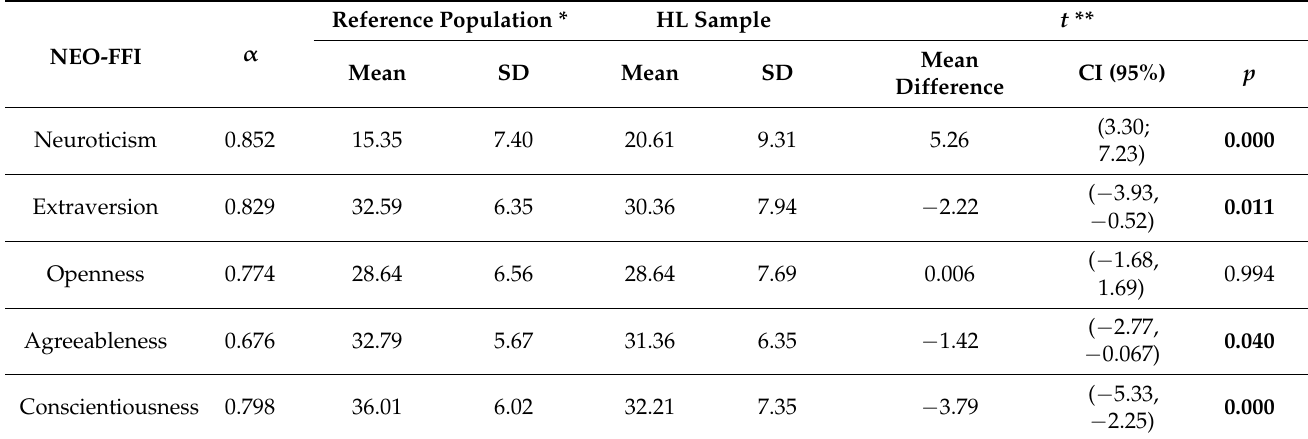
Table 3. Scores on general personality traits.